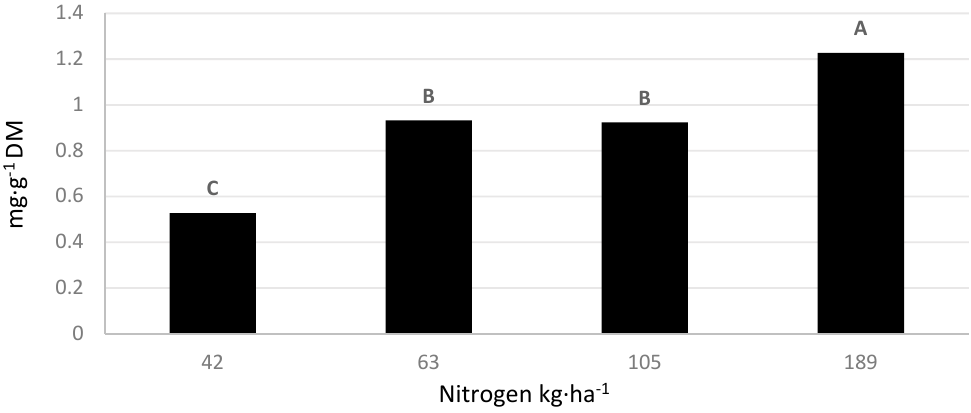
Figure 2. The effect of increasing nitrogen fertilization on the concentration of quercetin-3-glucoside concentrations in leaf tissue of ‘Salvius’ and ‘Thurinus’, red and green romaine lettuce cultivars, respectively. Values followed by the same letter are not significantly different at p ≤ 0.05 according to the Tukey’s Honest Significant Difference test. Table 2. The interaction of growing locations and lettuce cultivars on the concentrations of phenolic secondary metabolites quercetin-3-glucoside (Q-3-G) and quercetin/luteolin glucuronide (QL-G) in green and red romaine lettuce cultivars.